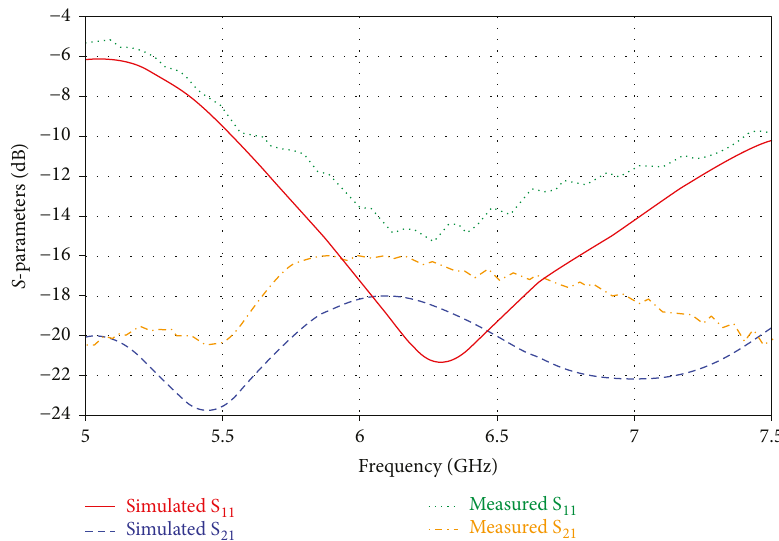
Figure 3: Comparison between the simulated and the measured S -parameter results.